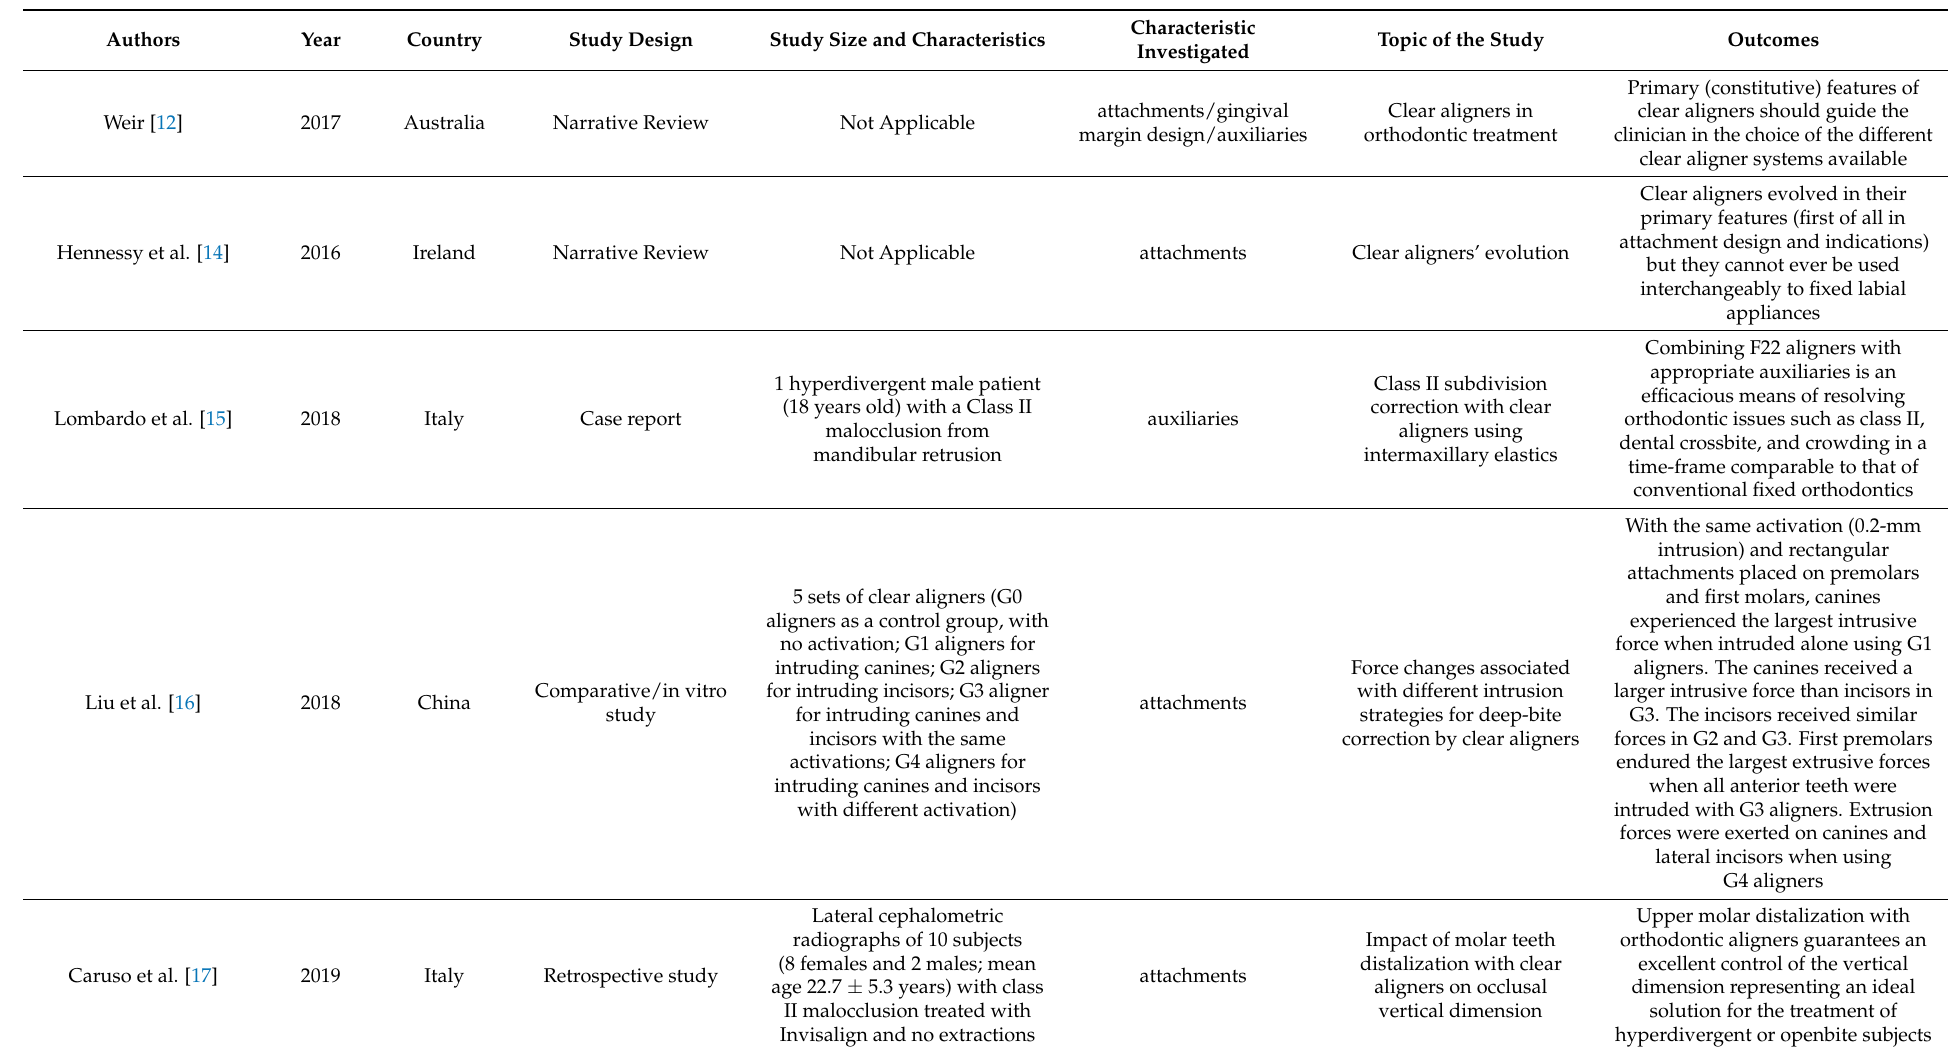
Table 2. Articles included in the